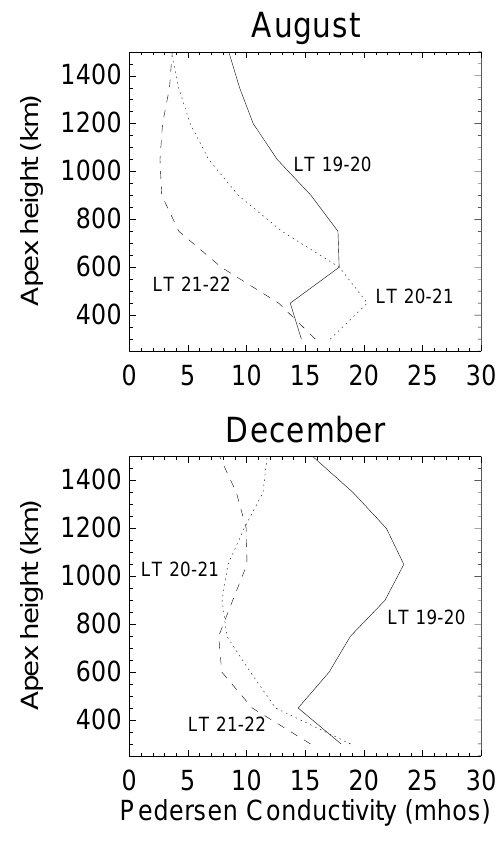
Fig. 4. Temporal evolution of the 6 F